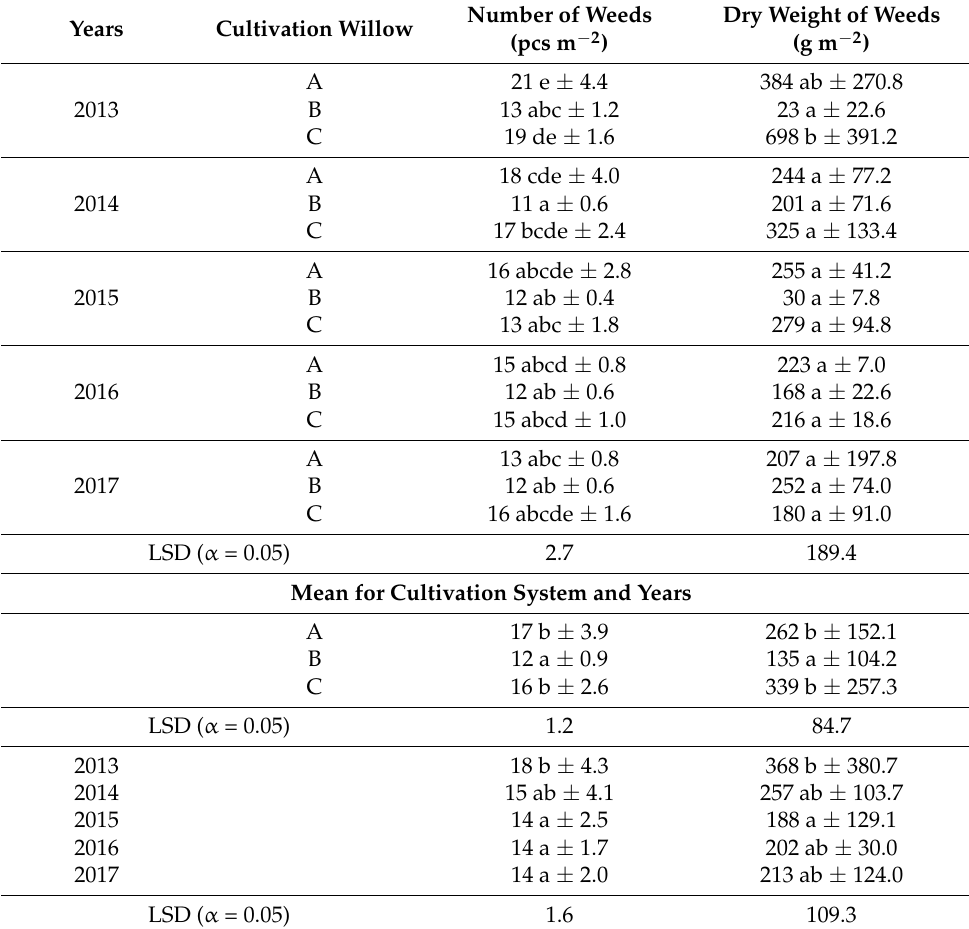
Table 4. Dry weight and number of